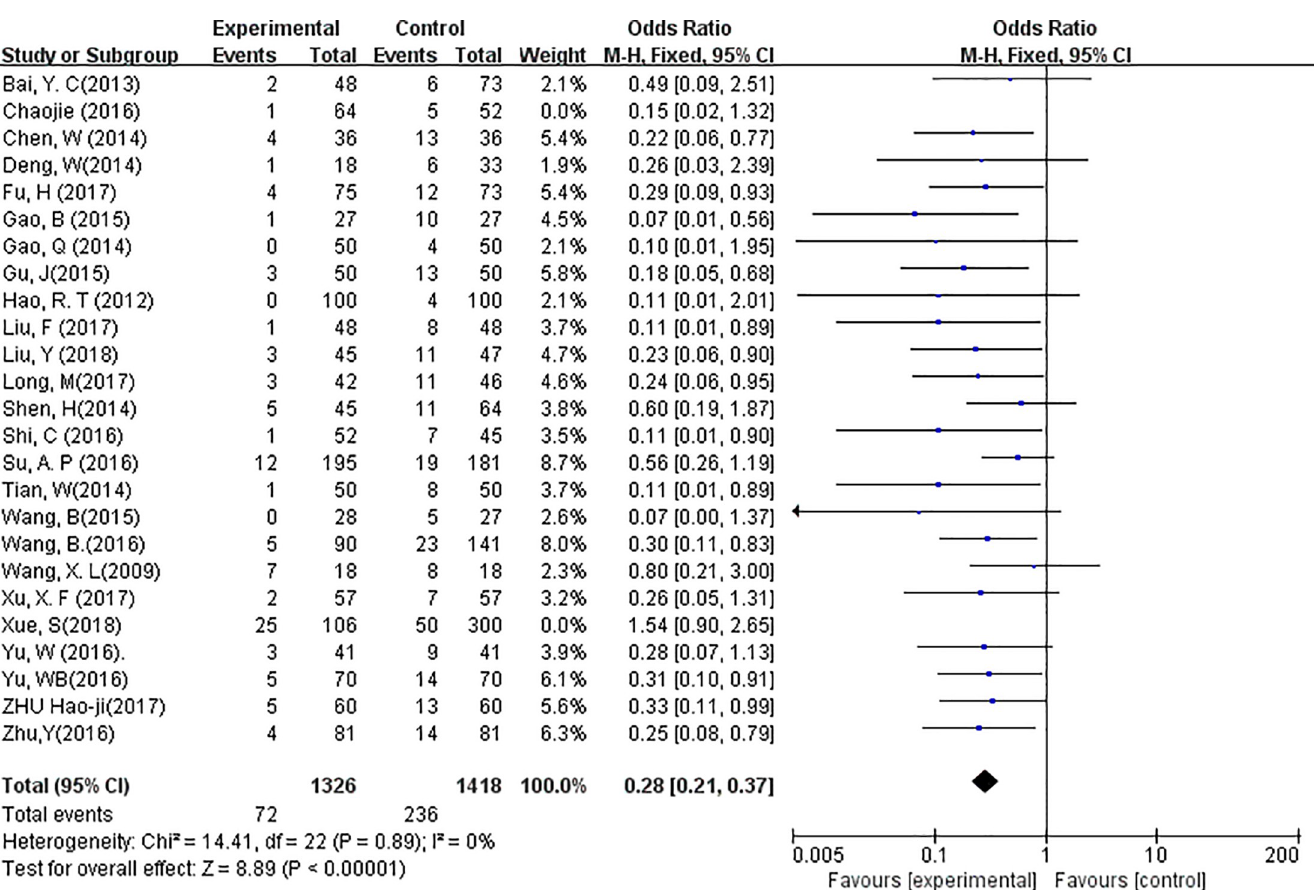
Fig 5. Forest plots of accidental parathyroid removal rate in groups. (Experimental = Carbon nanoparticle group, Control = Blank or methylene blue group, Total = The number of patient, Events = the number of parathyroid glands removed accidentally).